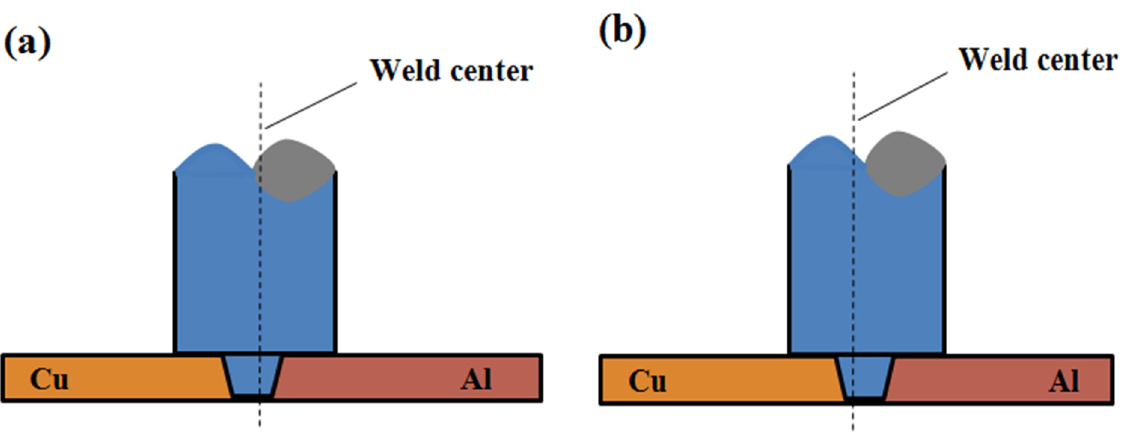
Figure 8. The tool bias principle: ( a ) the tool biased to the Cu side; ( b ) the tool biased to the Al